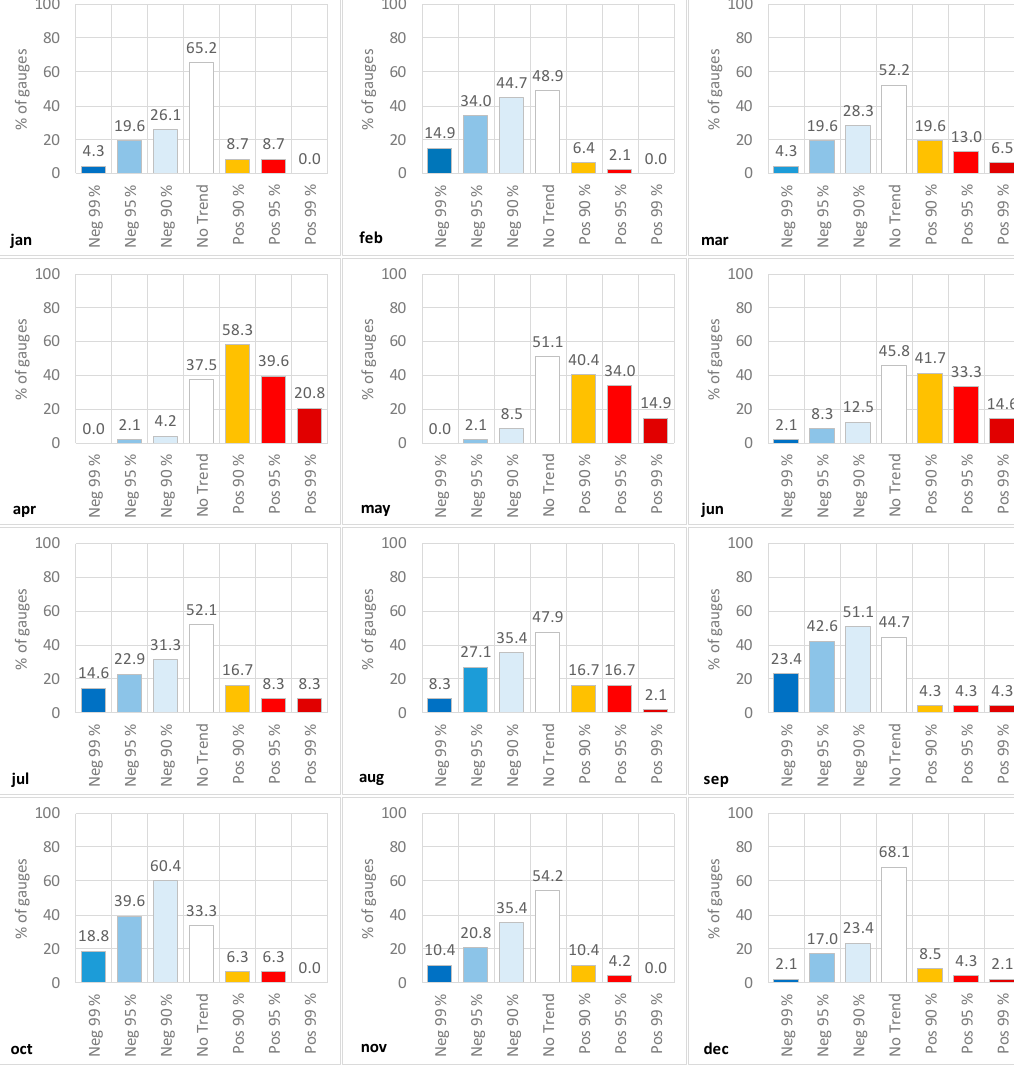
Figure 2. Percentages of minimum temperature series presenting positive or negative trend.